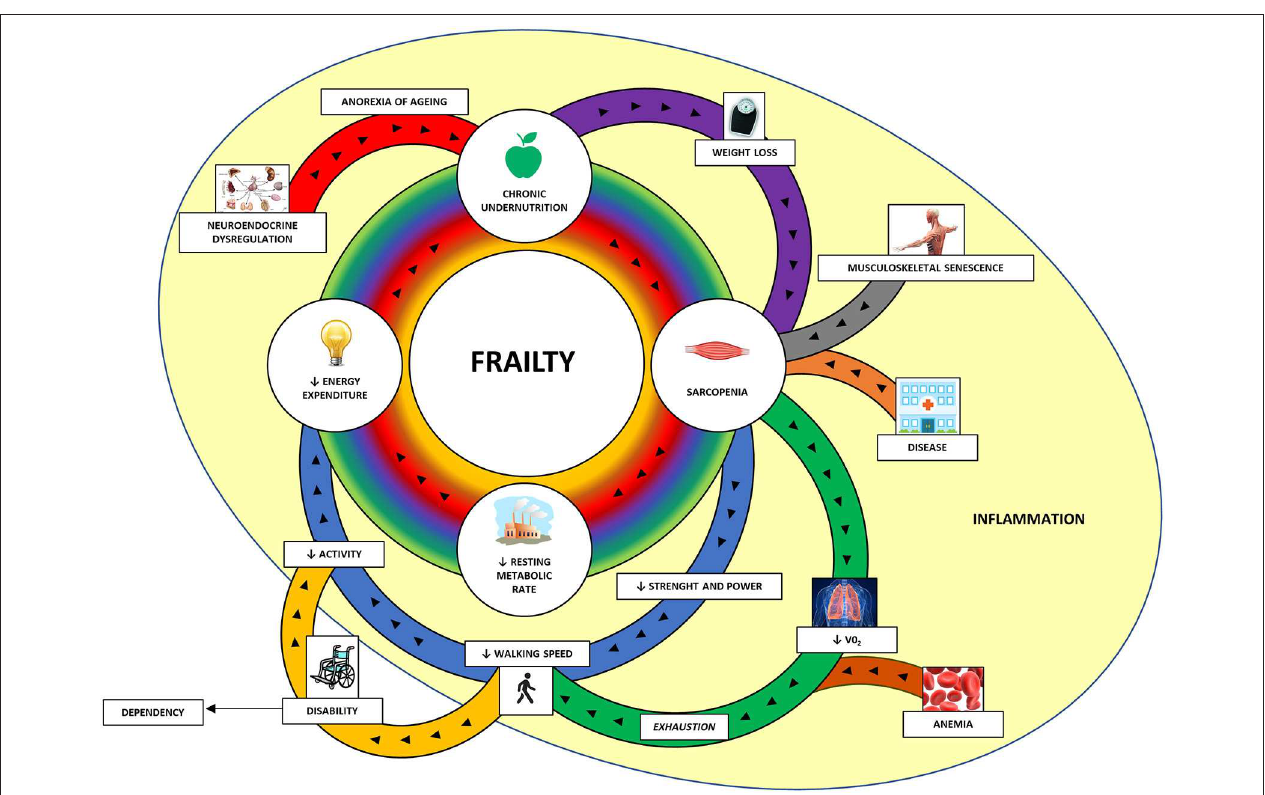
FIGURE 1 | The cycle of frailty (45). The four key factors of frailty (in the central circle) are sarcopenia, lower resting metabolic rate, lower energy expenditure, and chronic undernutrition. These factors are interconnected and amplifying the process and it is hard to distinguish the first factor that started it. In the peripheral area are represented the contributors to these factors. The main contributors to sarcopenia are weight loss (through protein and micronutrient deficit and increased catabolism), musculoskeletal senescence and various diseases. Sarcopenia itself, through the reduction of muscle strength and power, provokes one of the key features of the frailty assessment: the reduced walking speed. The diaphragm and visceral muscle sarcopenia along with anemia are responsible for reduced oxygen uptake (VO 2 ) and subsequent exhaustion, which contribute in slowing the walking speed. Reduced walking speed is associated with lower physical activity and subsequent lower energy expenditure. In some cases, the marked reduced walking capacity can configure a disability with loss of independency and need for assistance. Neuroendocrine dysregulation, frequently observed in older people, can reduce the appetite (anorexia of aging) and contribute to chronic undernutrition along with the lower energy expenditure with subsequent weight loss. A mild and chronic inflammation can have a negative impact in these processes. VO 2 , oxygen